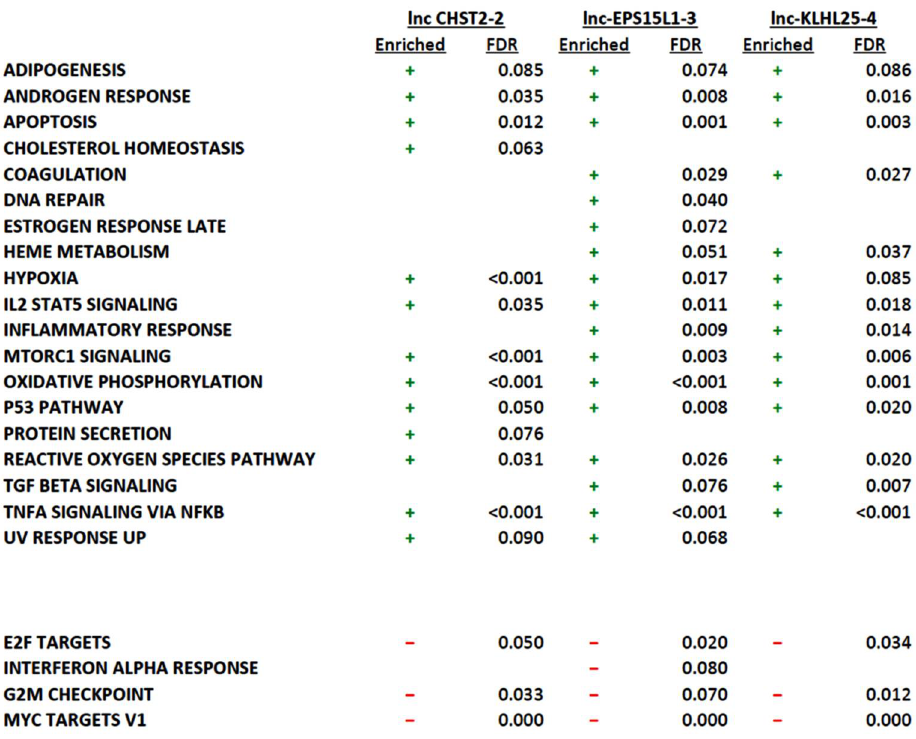
Figure 6. Overview of the pre-ranked GSEA of protein (anti-)correlated with the three unique LSC DE-lncRNAs, showing their involvement in different hallmark pathways (MSigDB) together with their respective FDR values. Plus and minus signs refer to enriched pathways and downregulated pathways within the respective lncRNAs.